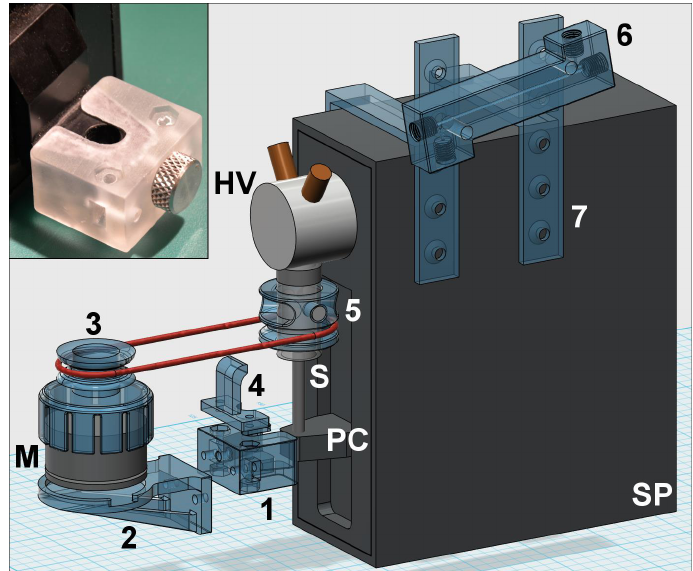
Figure 3. Lab-In-Syringe system from a syringe pump (SP) with 2 port head valve (HV) with an upright oriented syringe (S). 3D printed elements are shown in blue color and disassembled, required screws are not shown. A simple stir-driver (5) is connected to a motor (M), featured from a computer fan moving, with a removable top-attachment with pulley wheel (3) via a rubber band. On the piston carriage (PC), a universal adapter (1) allows fixing a holder for the motor (2) and a lifting lug (4) to move stir-driver and motor upwards with the syringe piston. An SLA-printed 5 cm detection flow cell (6) is mounted on top of the syringe pump using a universal adaptor (7). The photo shows the SLA-3D printed adaptor (item 1) for easy mounting additional elements to the piston carriage.